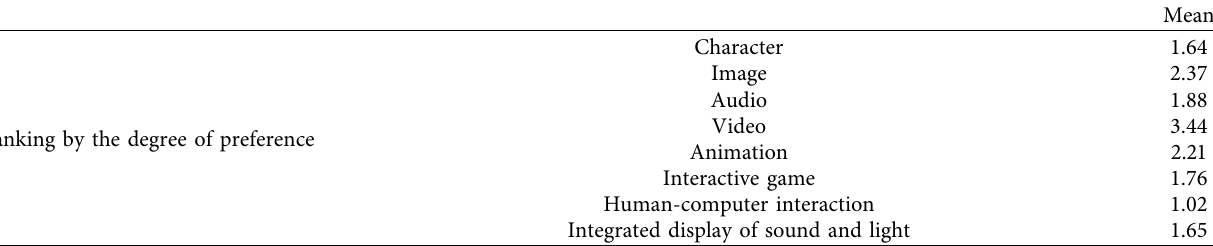
Table 15: Digital forms of the ICH works favored by the public.